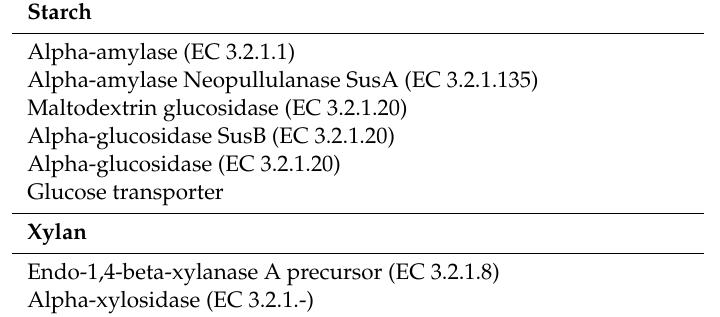
Table 3. Predicted enzymatic functions from SD_Bt-00010 genomic sequences that would be involved in the utilization of poly- and